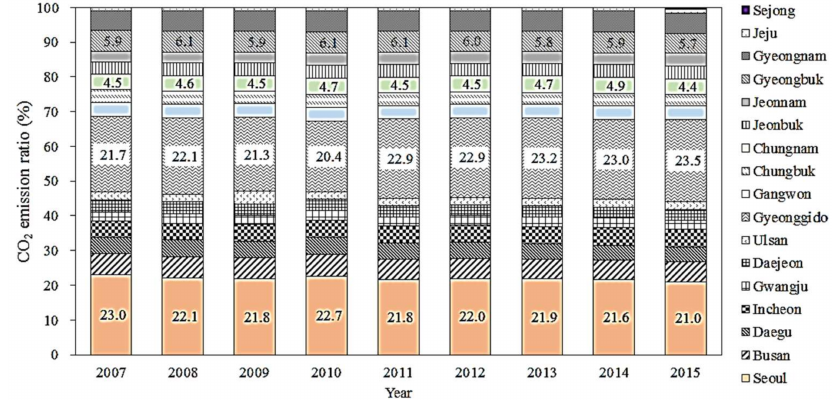
Figure 11. Percentage comparison of greenhouse emission in buildings by region